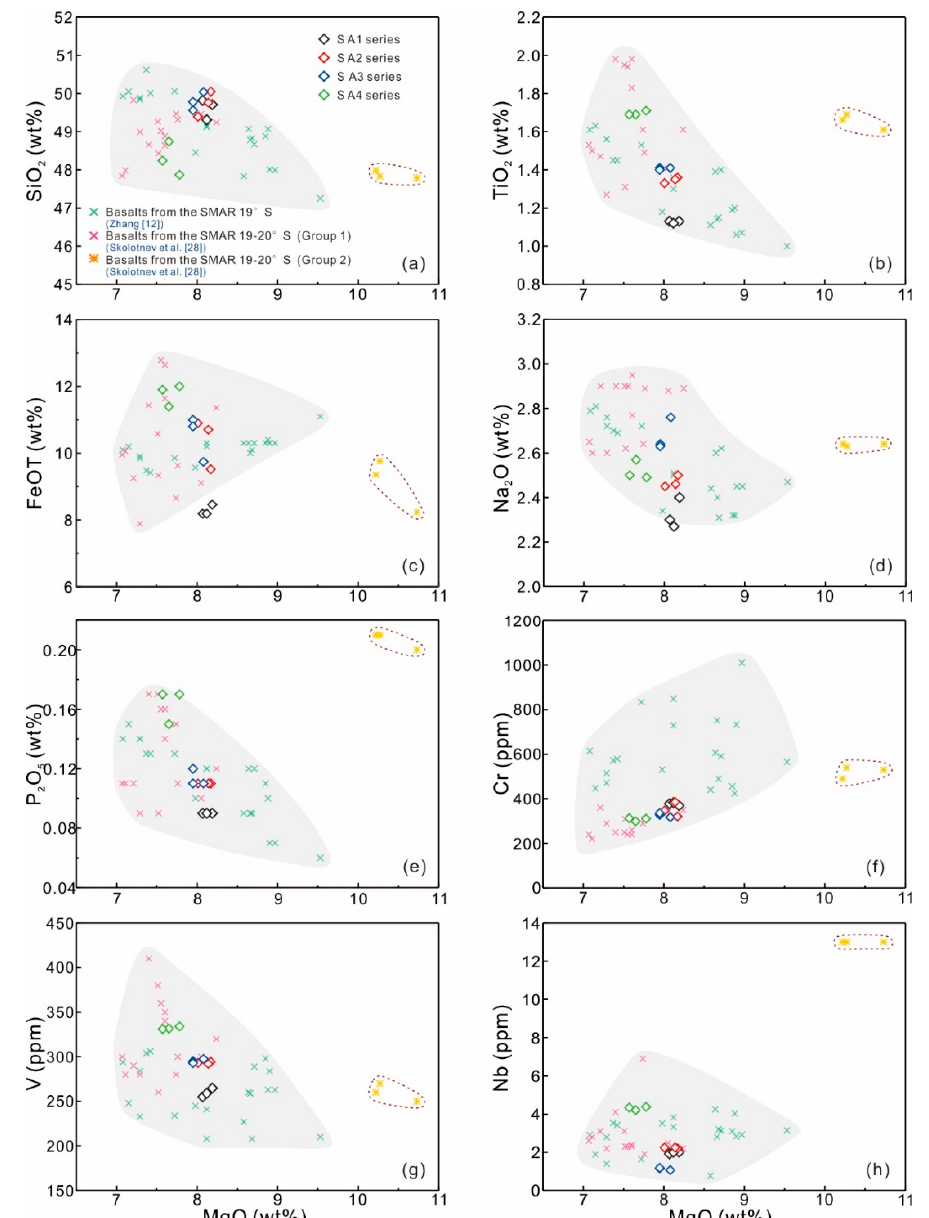
Figure 5. Major and trace element variation diagrams of the SMAR basalt samples from this study and from previous work. Data for basalts from the SMAR 19 ◦ –20 ◦ S are from [12,28]. Excluding major element SiO 2 ( a ), the SMAR basalts combined with these basalts from previous study (excluding the Group 2 basalt samples from the SMAR 19 ◦ –20 ◦ S presented by Skolotnev et al. [28]) exhibit negative correlations of TiO 2 , FeOT, Na 2 O, P 2 O 5 , V, and Nb with MgO ( b – e , g – h ), whereas they display a positive correlation between Cr and MgO ( f ).